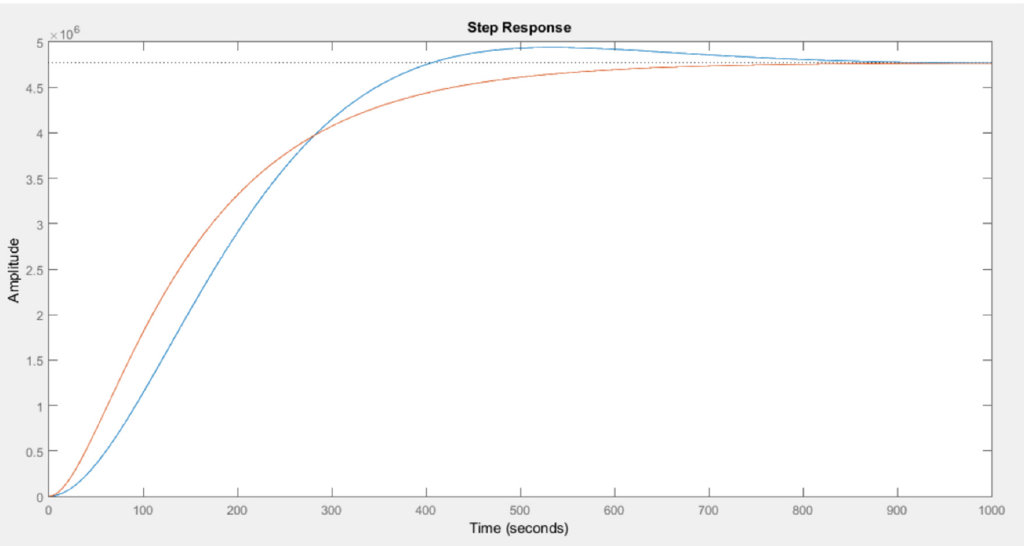
Figure 5. Length = 50 km, diameter = 0.7 m, mass flow = 60 kg/s.